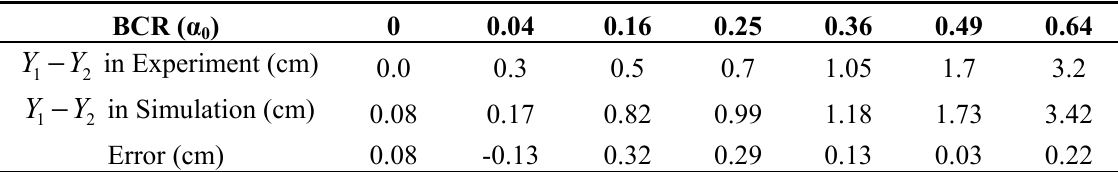
Table 4. Comarisons of difference between upsream and downstream water depth of experiment and simulation